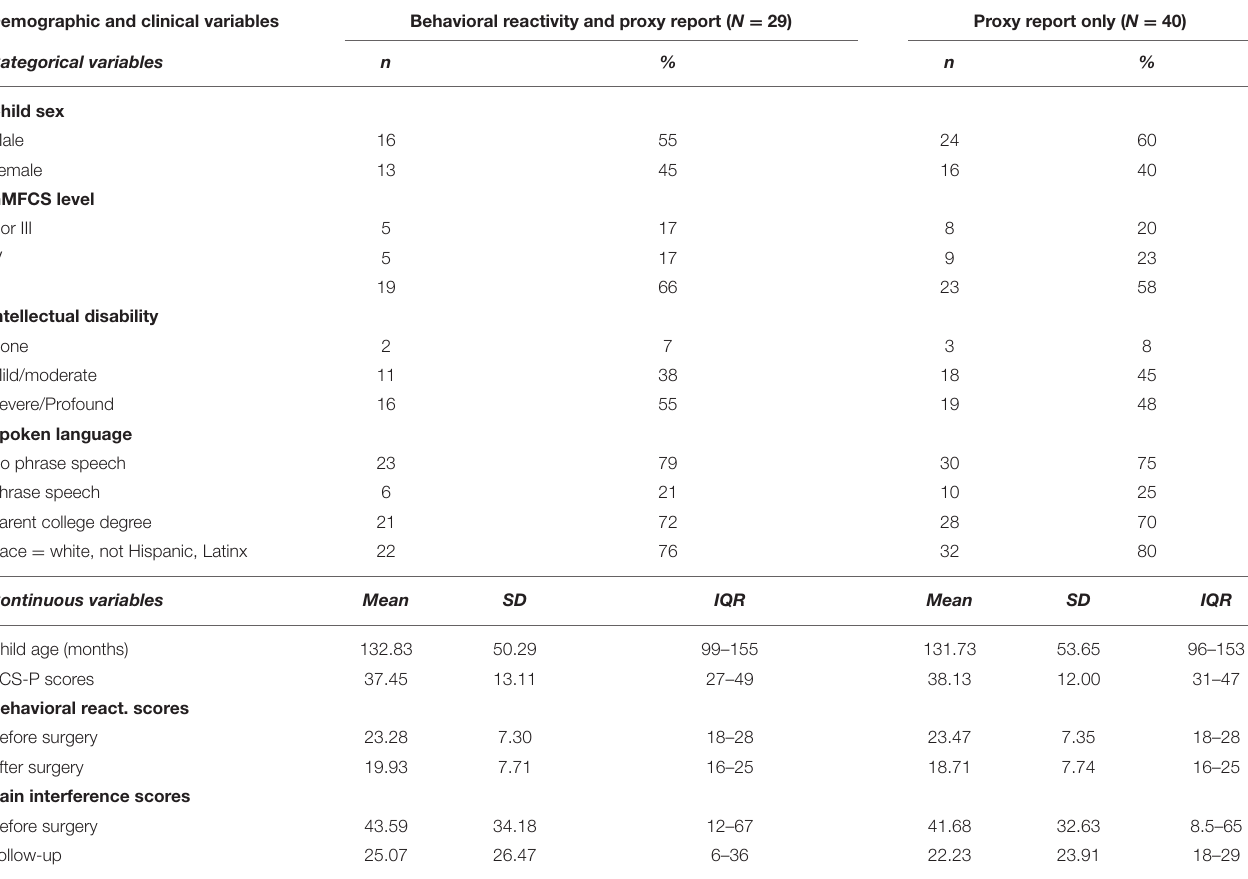
TABLE 1 | Participant dyad demographics by analysis. Demographic and clinical